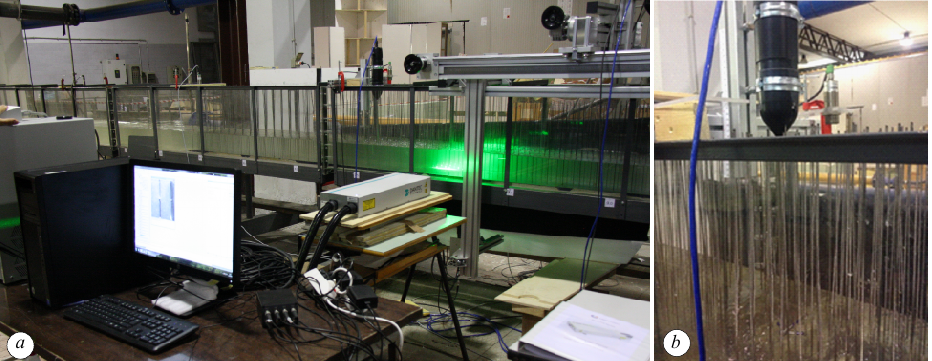
Figure 3. ( a ) View of the flume section with the Particle Image Velocimetry (PIV); ( b ) the particulars of an ultrasonic probe and